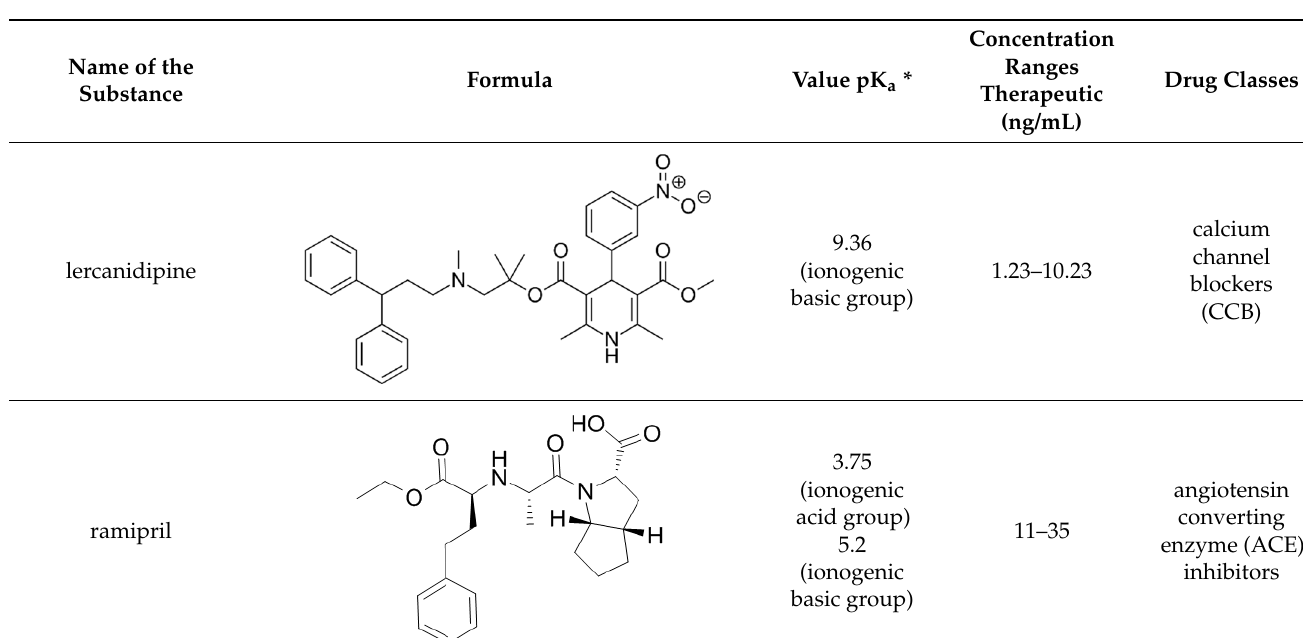
Table 5. A short description of the substances studied.